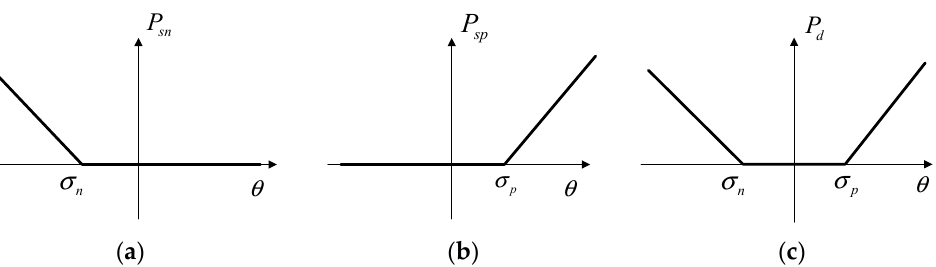
Figure 7. Penalty functions for suitable joint angles. ( a ) single-sided negative function, ( b ) single- sided positive function, and ( c ) double-sided function.